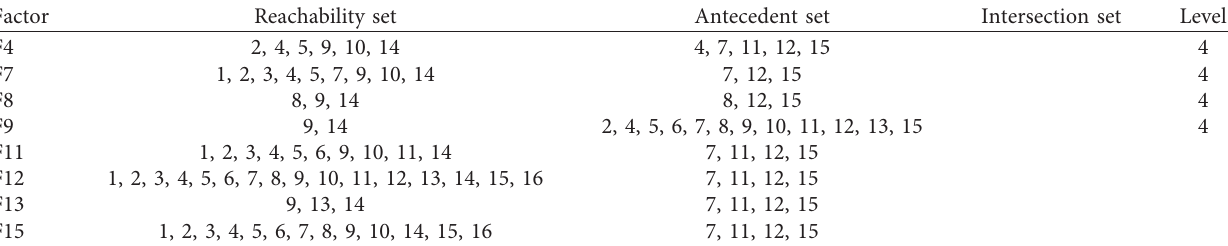
Table 7: Level partitions for level 4.